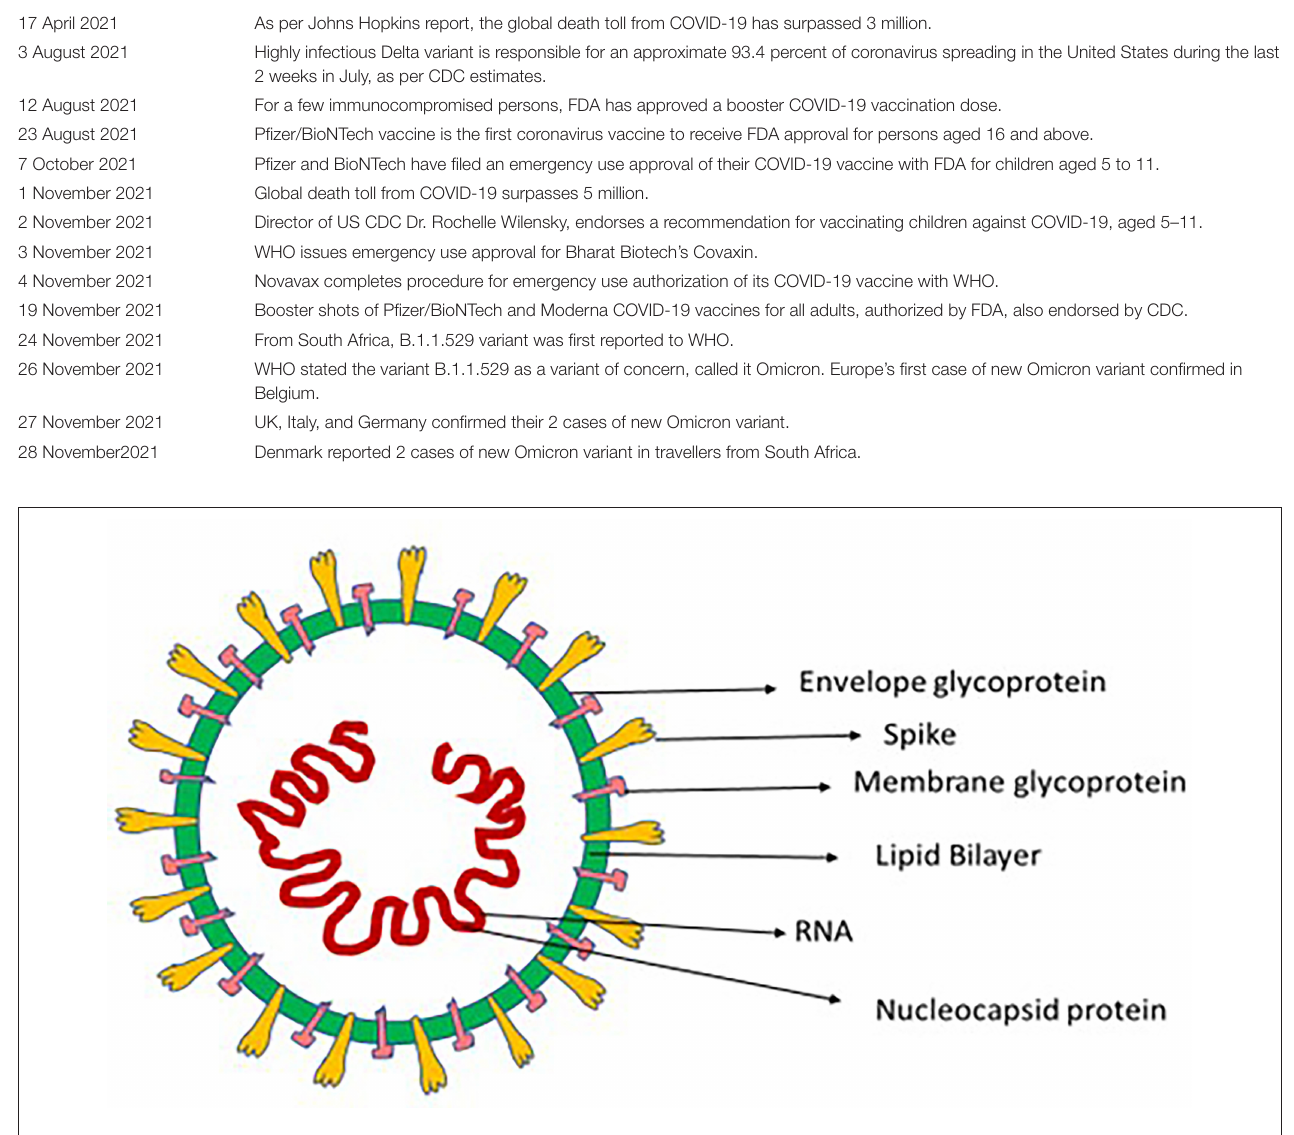
variant was found in United